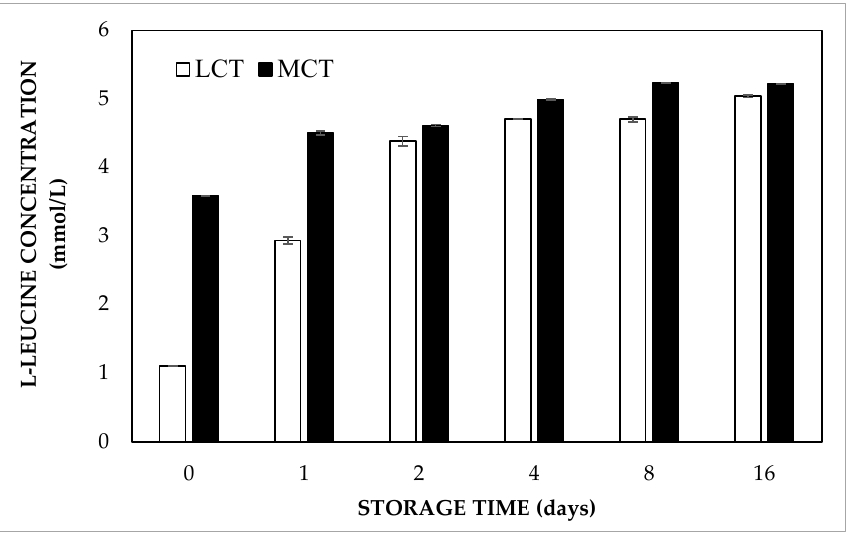
Figure 4. Released concentrations of L-leucine in double emulsions containing either MCT or LCT oil at 37 °C.